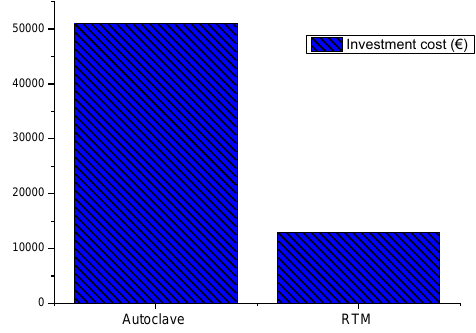
Figure 10. Investment cost of autoclaving and RTM.